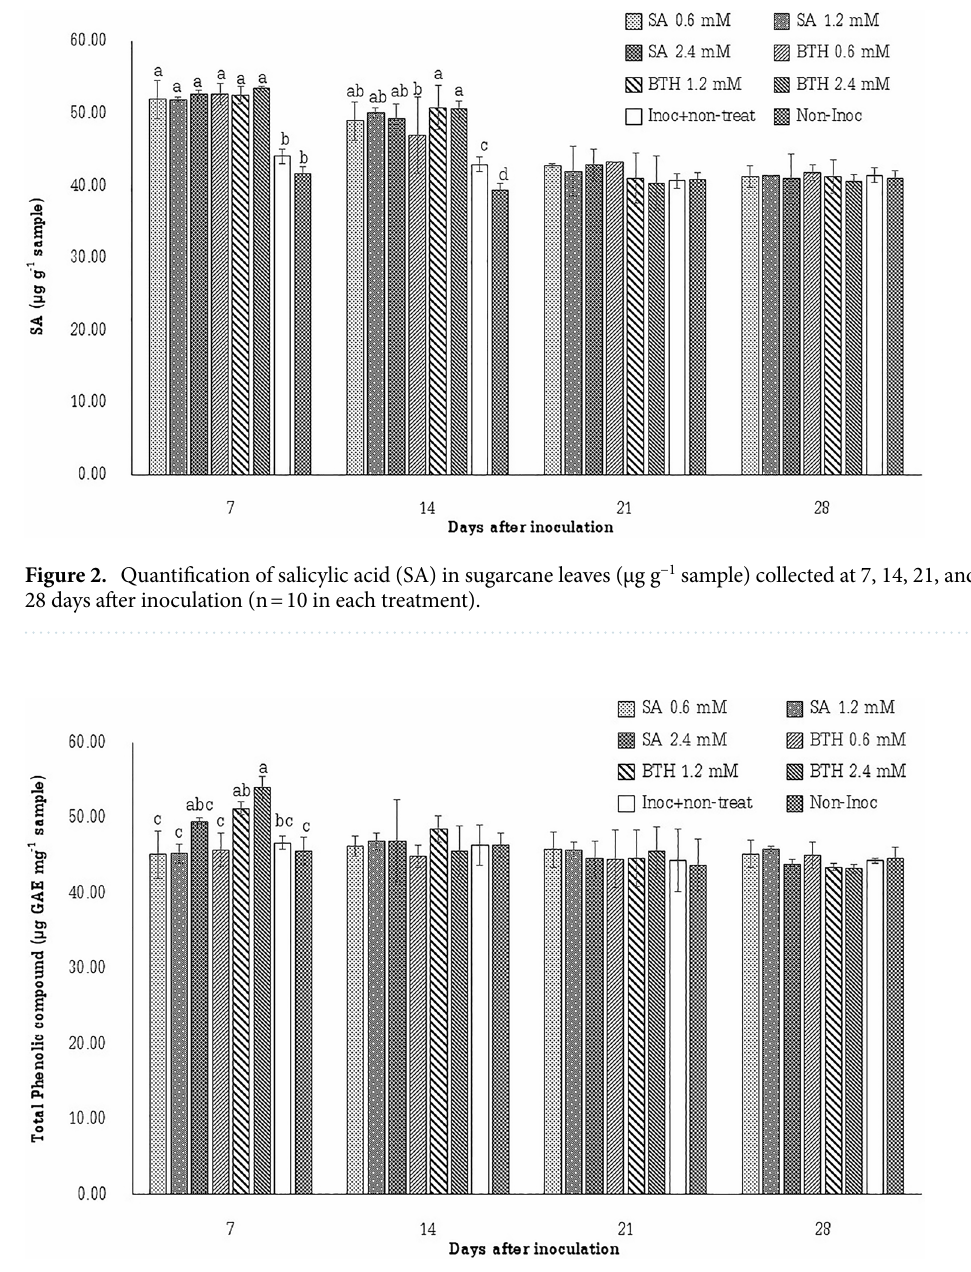
Figure 3. Quantification of total phenolic compound in sugarcane leaves (µg GAE mg −1 sample) collected at 7, 14, 21, and 28 days after inoculation (n = 10 in each